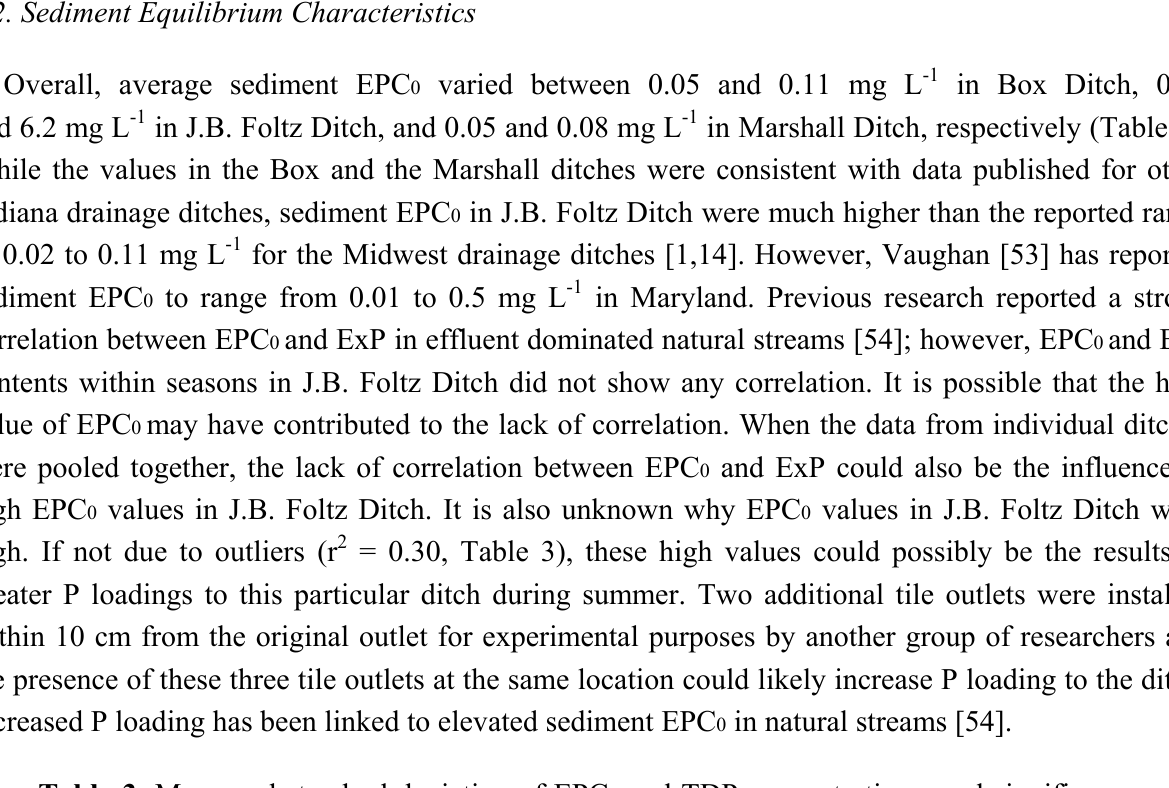
Table 3. Mean and standard deviation of EPC 0 and TDP concentrations, and significance of EPC 0 estimation in the three ditches during the study period. An Asterisk (*) indicates that there is a significant difference between EPC 0 and TDP